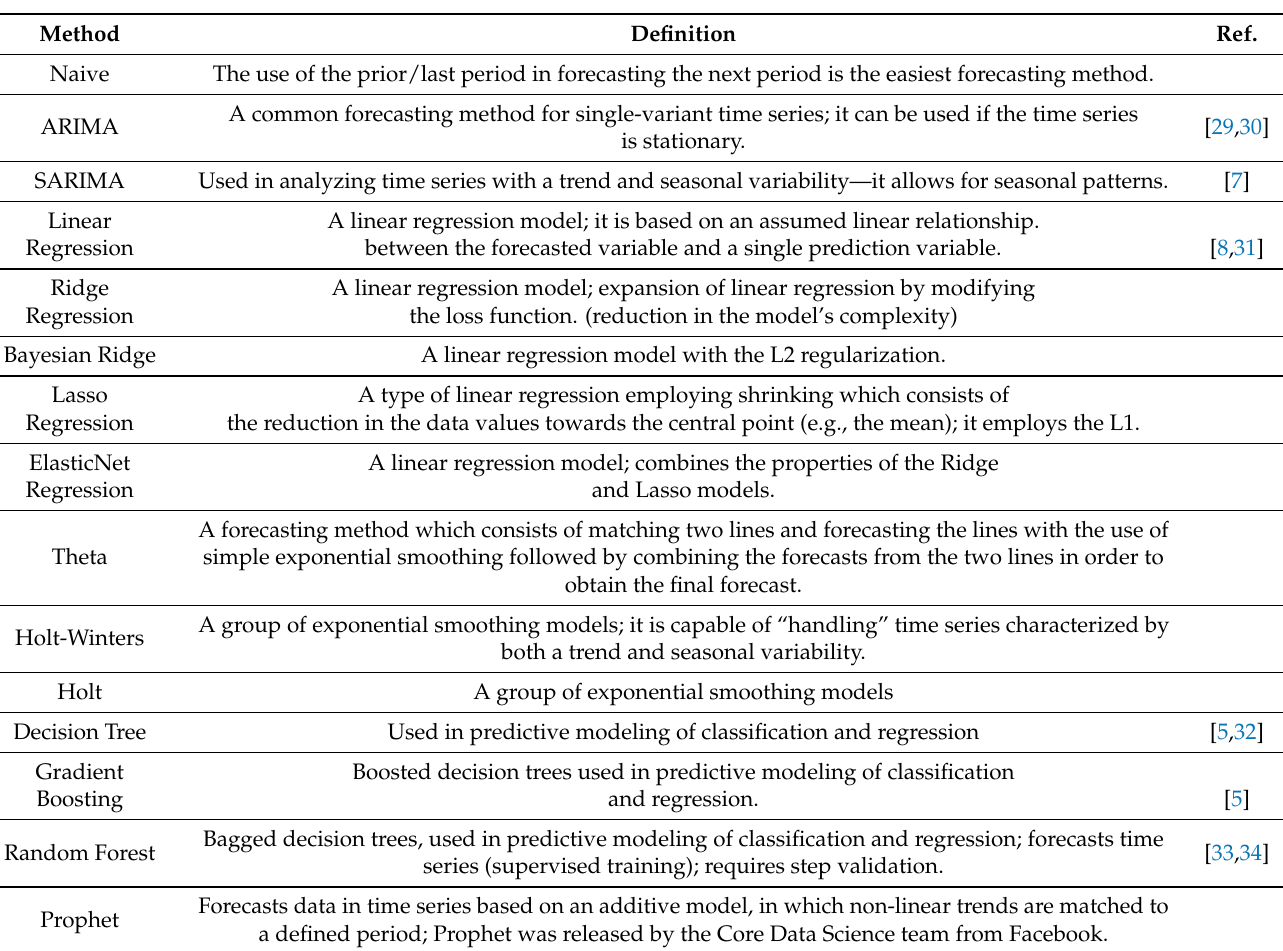
Table 2. Basic information of SAR data and SBAS results used in forecasting. The third column includes literature references (if applicable).